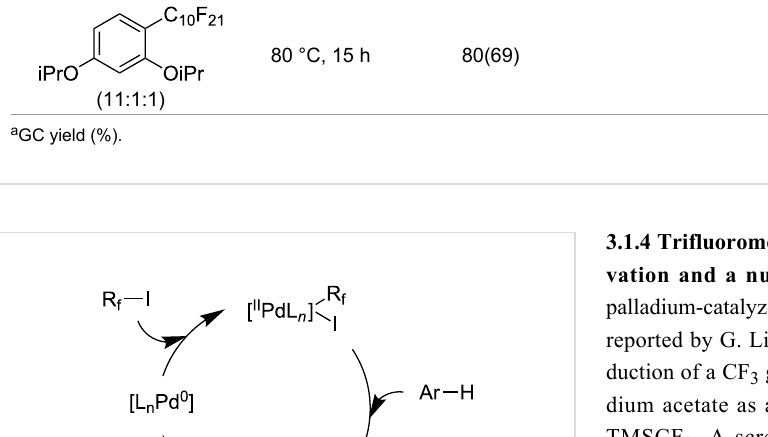
80 °C, 15 h 80(69)